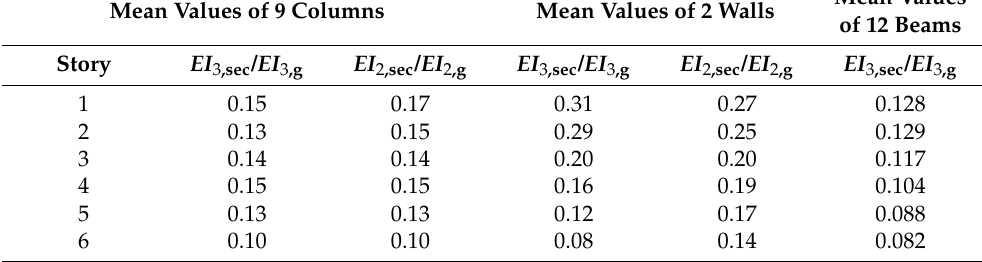
Table 2. Mean values of the ratio EI sec / EI g of the secant stiffness at yield to the geometric stiffness in each story, separately for the columns, walls, and beams. The local axes of structural elements are denoted by 2 and 3, where 3 is normal to their strong